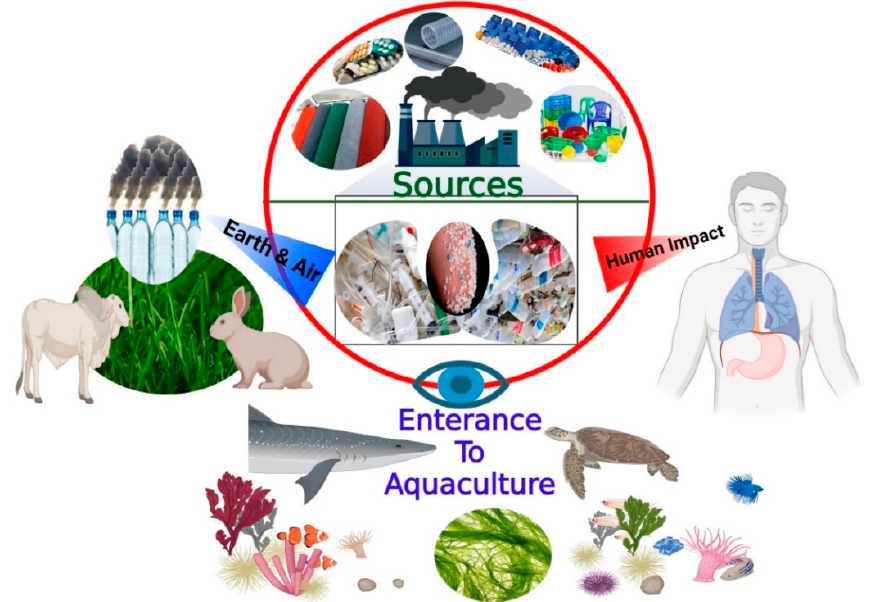
Figure 1. A schematic diagram showing the main sources, entrance, and widespreadness of MNPs in the environment, extending to humans.